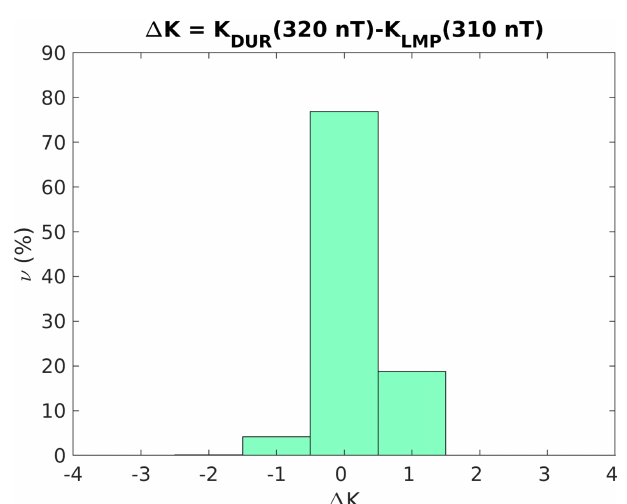
Figure 6. Frequency distribution of (cid:49) K = K DUR − K LMP , where K indices are computed by KASM using L9 = 320 and L9 = 310nT for DUR and LMP,